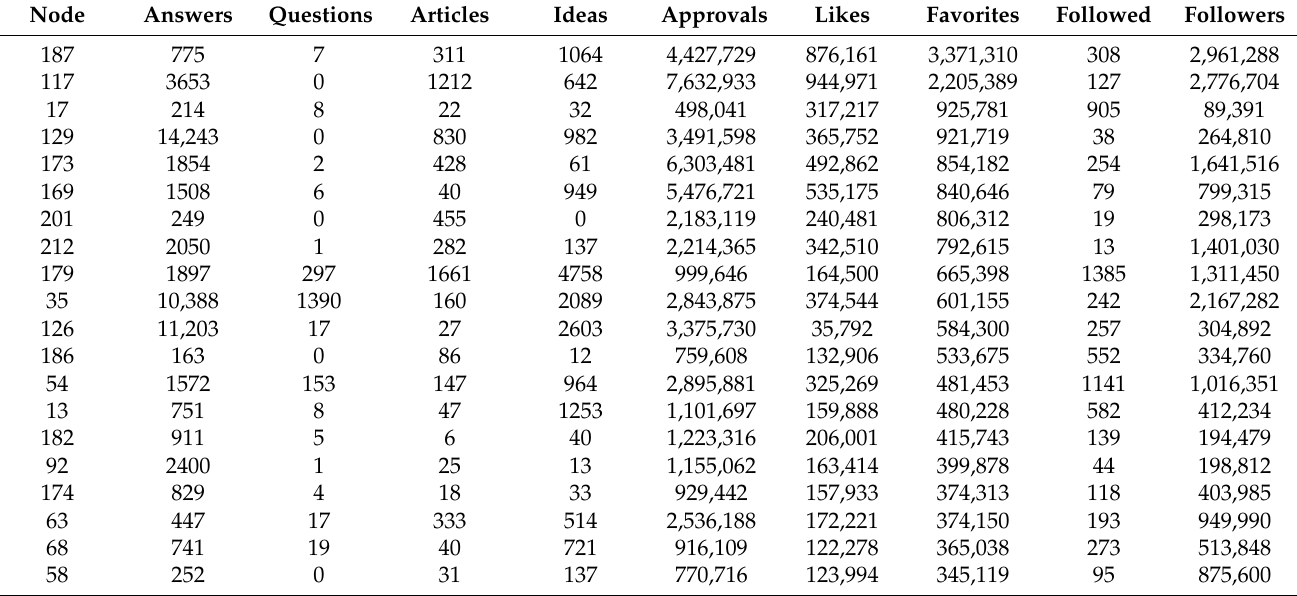
Table 1. Information about opinion leaders (the top 20).